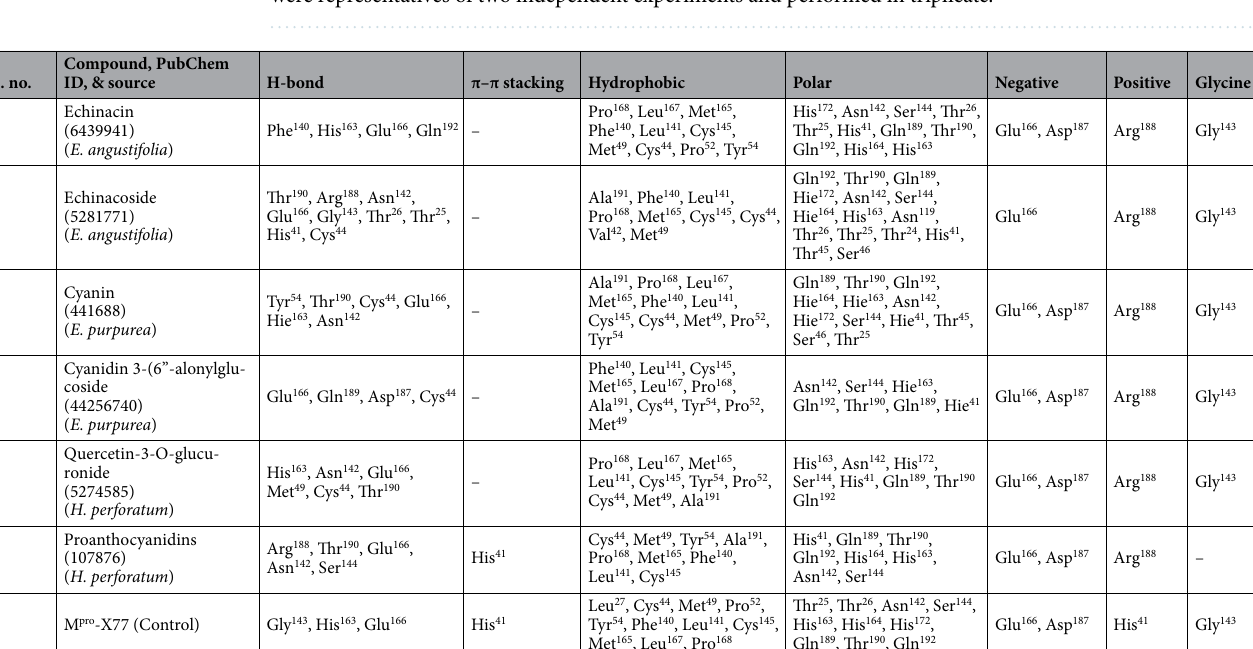
(Table 1). Notably, SARS-CoV-2 M pro -Echinacin complex analysis, four hydrogen bonds formation were observed with Echinacin and Phe 140 , His 163 , Glu 166 , and Gln 192 residues of SARS-CoV-2 M pro while Thr 190 , Arg 188 , Asn 142 , Glu 166 , Gly 143 , Thr 26 , Thr 25 , His 41 , and Cys 44 residues of SARS-CoV-2 M pro formed ten hydrogen bonds with Echinacoside from E. angustifolia (Fig. 5). Cyanin from E. purpurea formed six hydrogen bonds with Tyr 54 , Thr 190 , Cys 44 , Glu 166 , Hie 163 , and Asn 142 while Cyanidin 3-(6 ʺ -malonylglucoside) formed five bonds with Glu 166 , Gln 189 , Asp 187 , and Cys 44 residues of SARS-CoV-2 M pro (Fig. 5). Quercetin-3-O-glucuronide from H. perforatum formed six hydrogen bonds with His 163 , Asn 142 , Glu 166 , Met 49 , Cys 44 , and Thr 190 while Proanthocyanidins formed five hydrogen bonds with Arg 188 , Thr 190 , Glu 166 , Asn 142 , and Ser 144 residues of SARS-CoV-2 M pro (Fig. 5). The